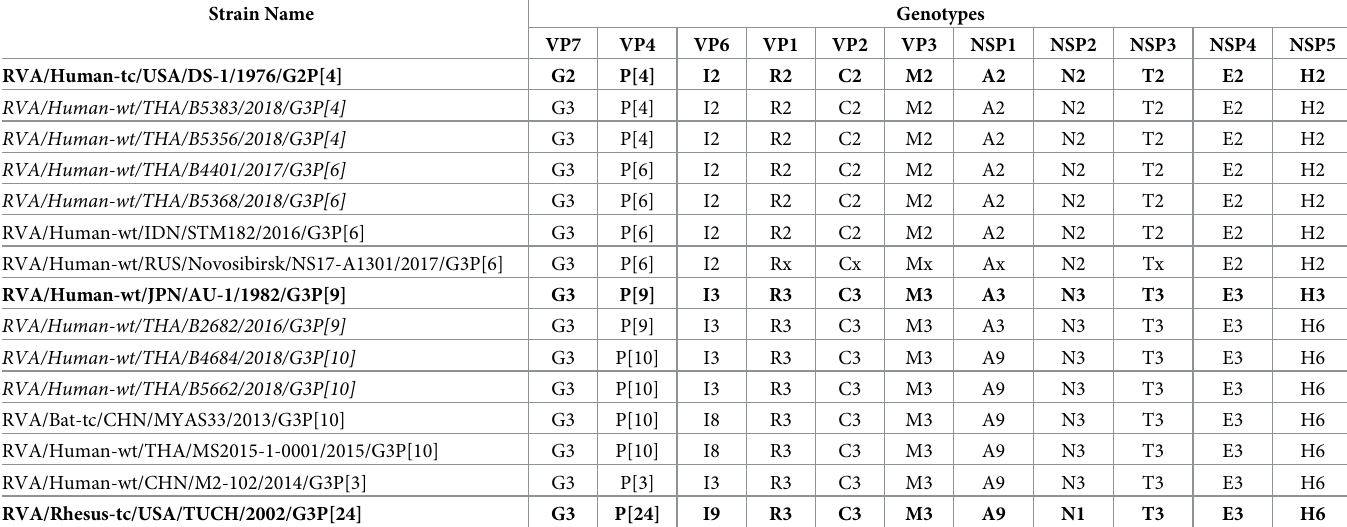
Table 2. Genome constellations of RVA G3 characterized in this study (in italics) compared to several RCWG reference (in bold) and global strains. Strain Name